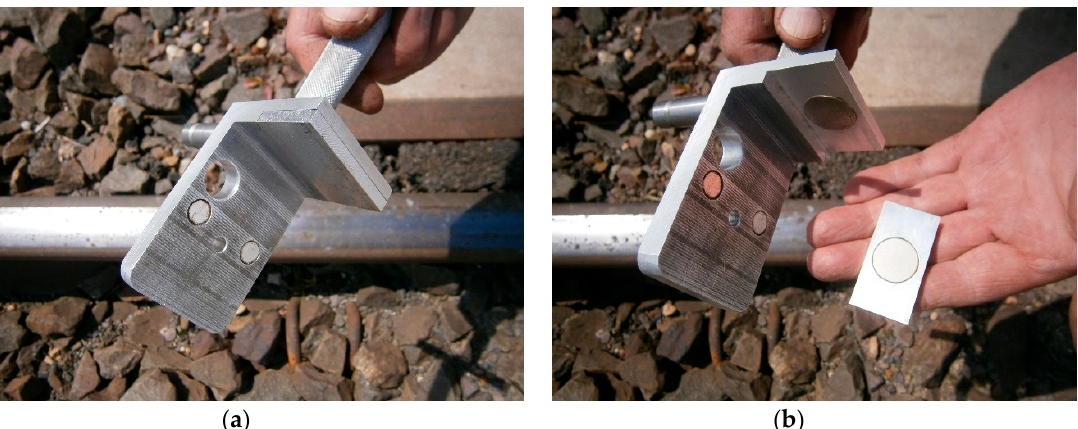
Figure 4. Magnetic base in MMS construction for mounting on metal parts: ( a ) with a reduction plate; and, ( b ) without a reduction plate.